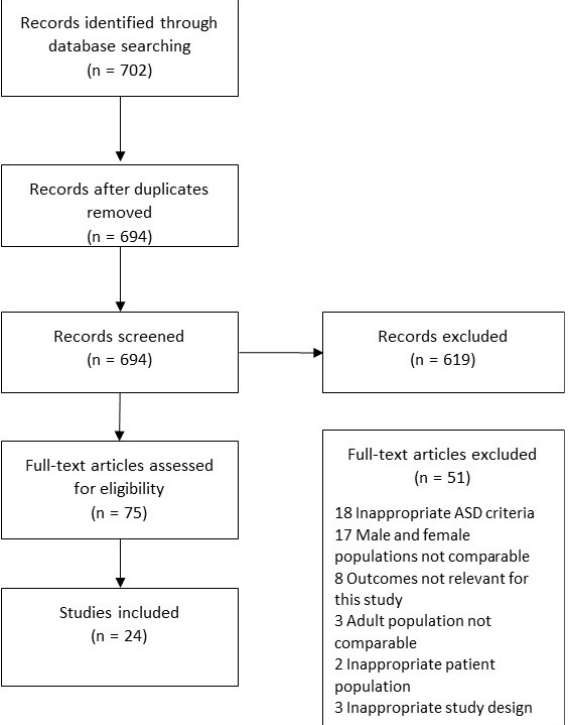
Figure 1. Flowchart of Preferred Reporting Items for Systematic Reviews and Meta-Analyses (PRISMA) detailing study.